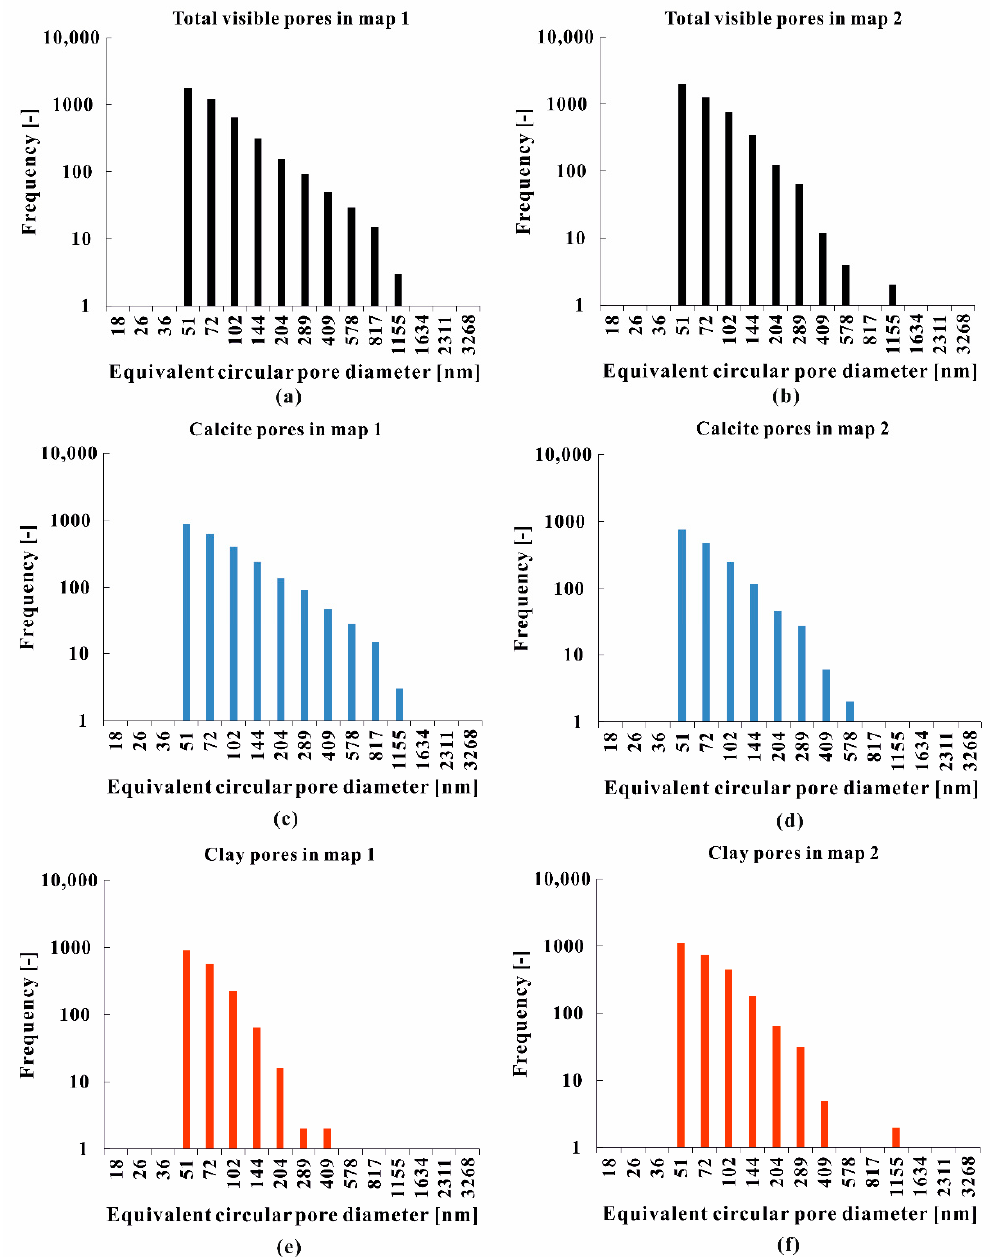
Figure 8. Pore frequency distributions (pore frequency vs equivalent circular pore diameter) of total visible pores in BIB-SEM map 1 ( a ) and map 2 ( b ). Pore frequency distributions of visible pores in calcite ( c ) and clay mineral ( e ) phases of map 1. Pore frequency distributions of visible pores in calcite ( d ) and clay mineral ( f ) phases of map 2.